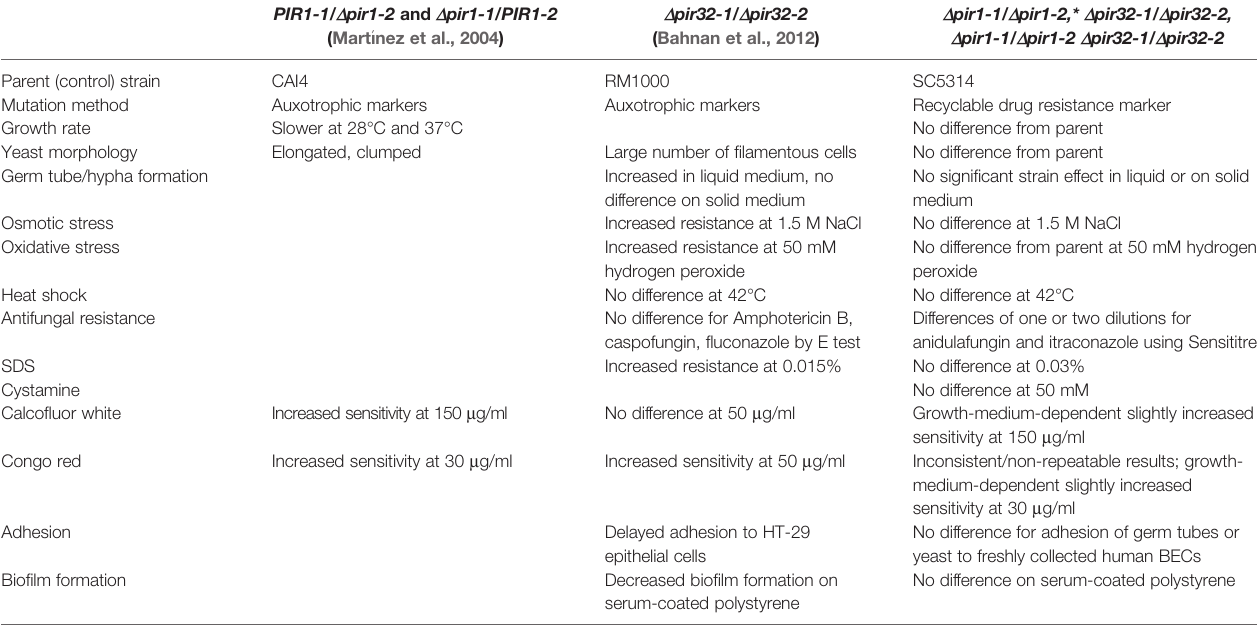
TABLE 1 | Comparison between published phenotypes for C. albicans strains with mutations in PIR genes and results from the current